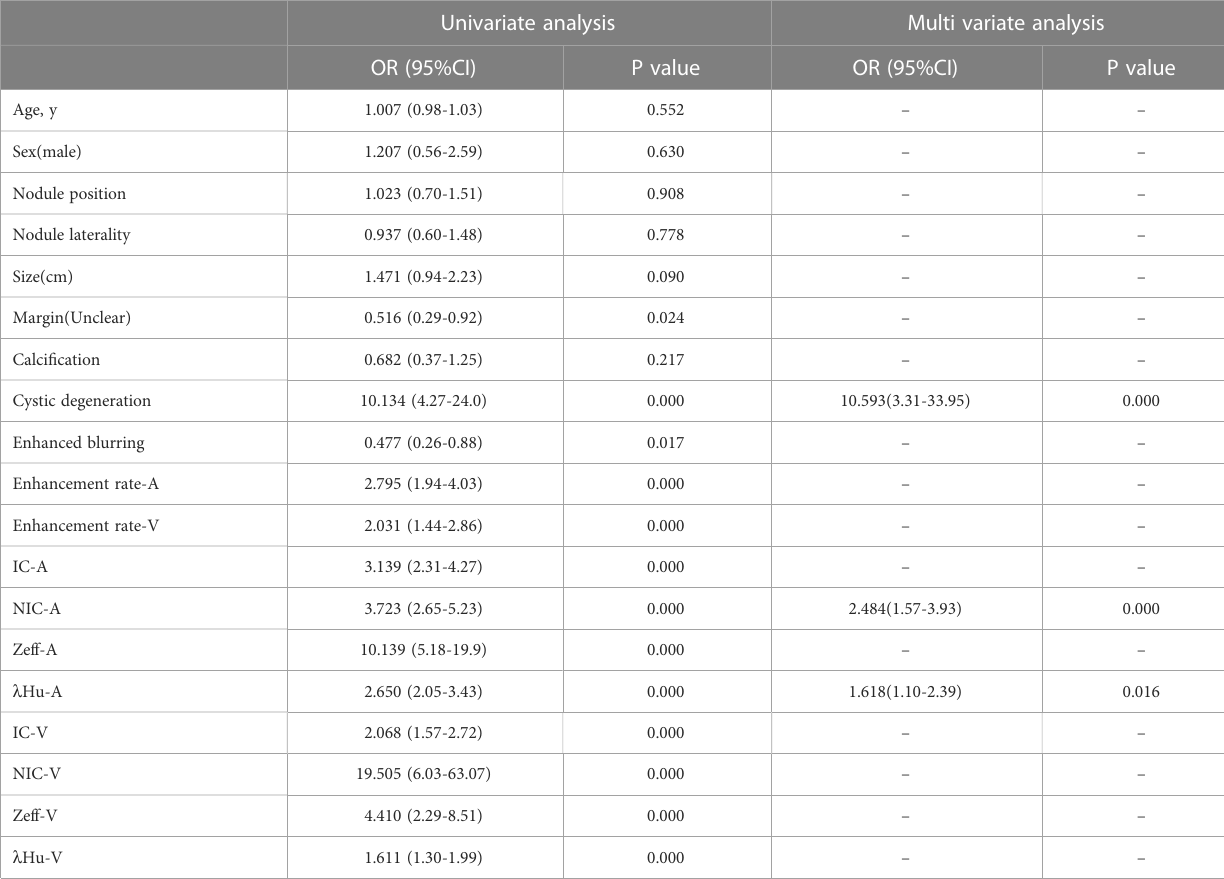
TABLE 2 Univariate Logistic Regression and Multivariate Logistic Regression Results for Training Cohorts.